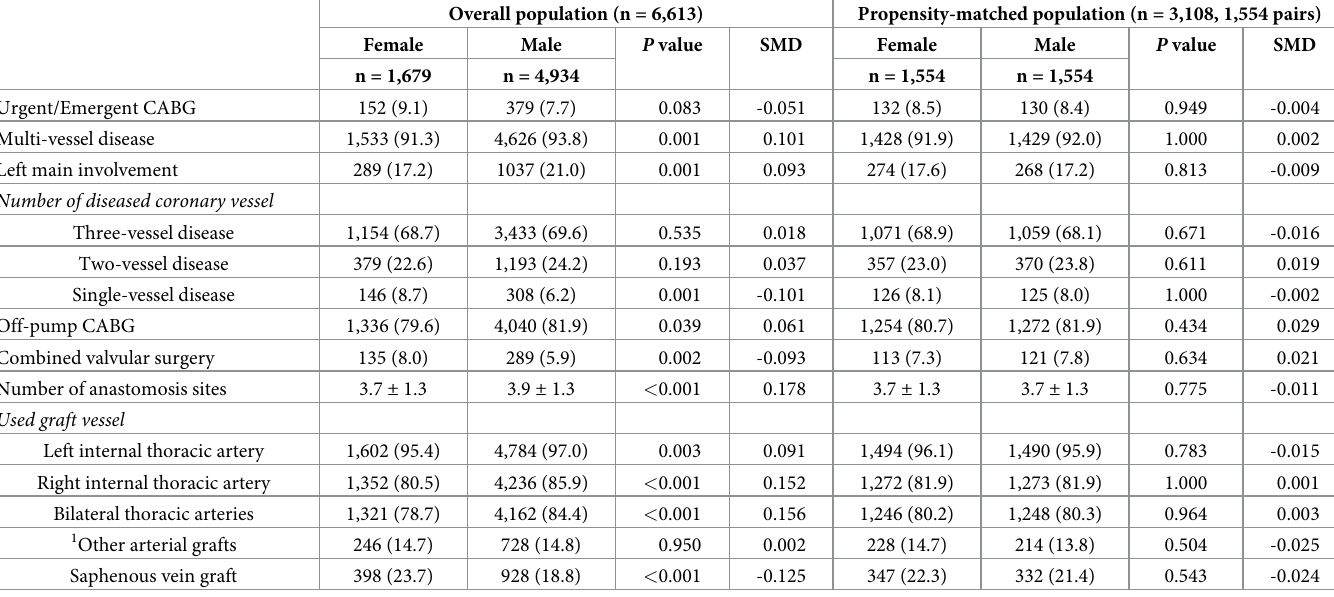
Table 2. Coronary anatomy and procedural